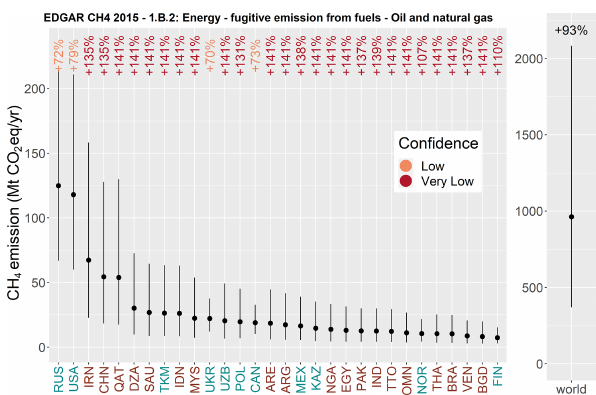
Figure 5. Methane emissions from the top emitters and the world for sector 1.B.2 (energy – fugitive emissions from oil and natural gas) with a revised u EF and u AD (see text). Colour codes are the same as in Fig.